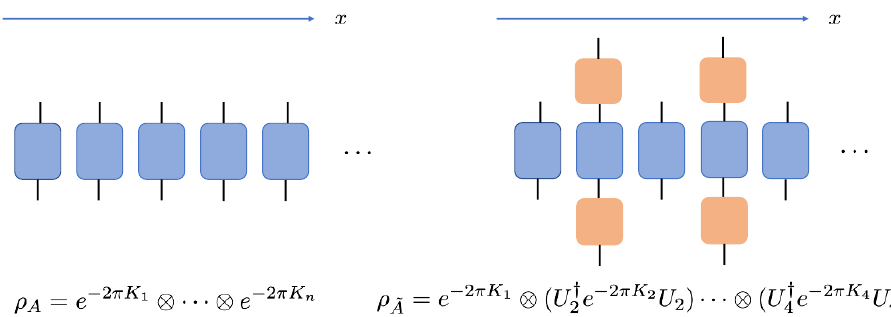
Figure 3 . (a) The density matrix of the half-space on a null sheet factorizes in free (cid:12)eld theory (b) a shape deformation on the null sheet at point x = a corresponds to acting with unitaries U a